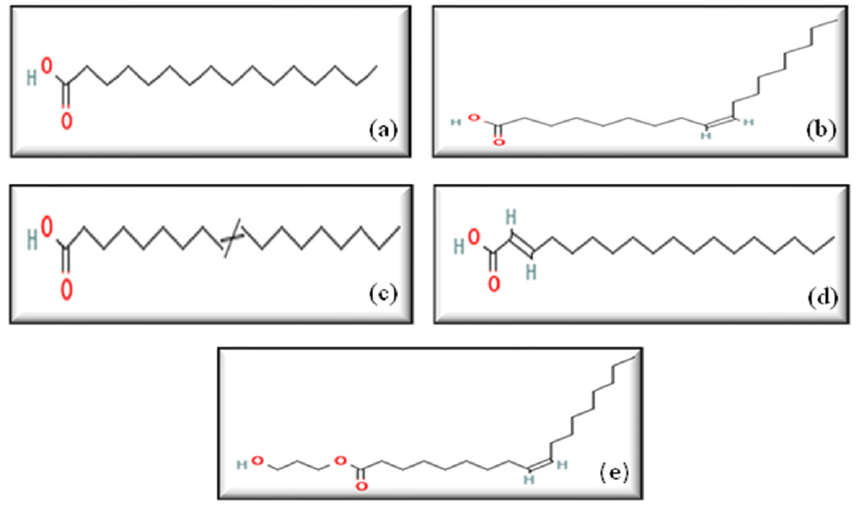
Figure 10. Chemical structure of main fatty acid components in Malaysian Jatropha seed oil. ( a ) n-Hexadecanoic acid ( b ) Oleic acid ( c ) 9-Octadecenoic acid, (E)- ( d ) Octadecenoic acid ( e ) Oleic acid, 3-hydroxypropyl ester.